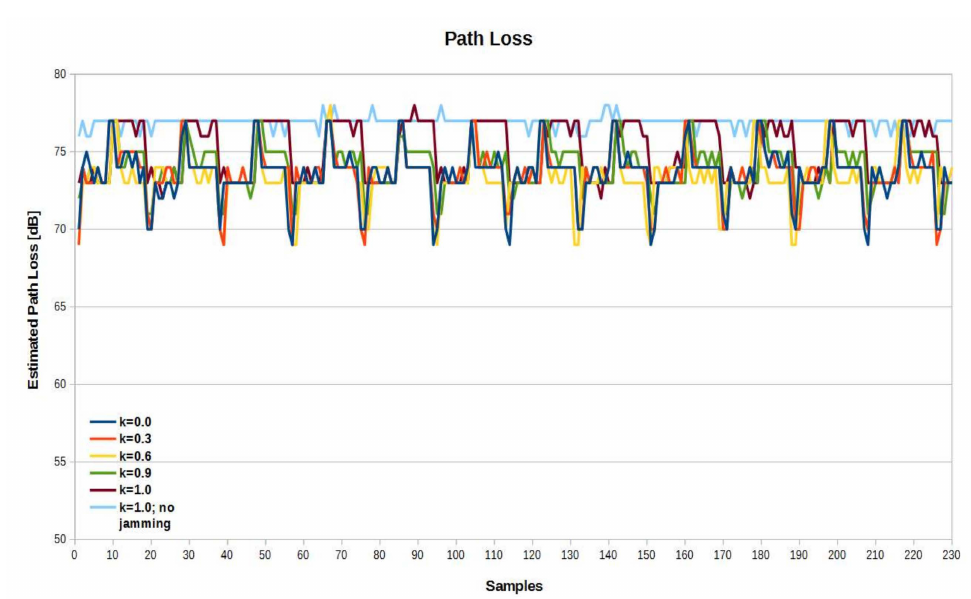
Figure 19. Path loss values without attenuator in the effector antenna path.